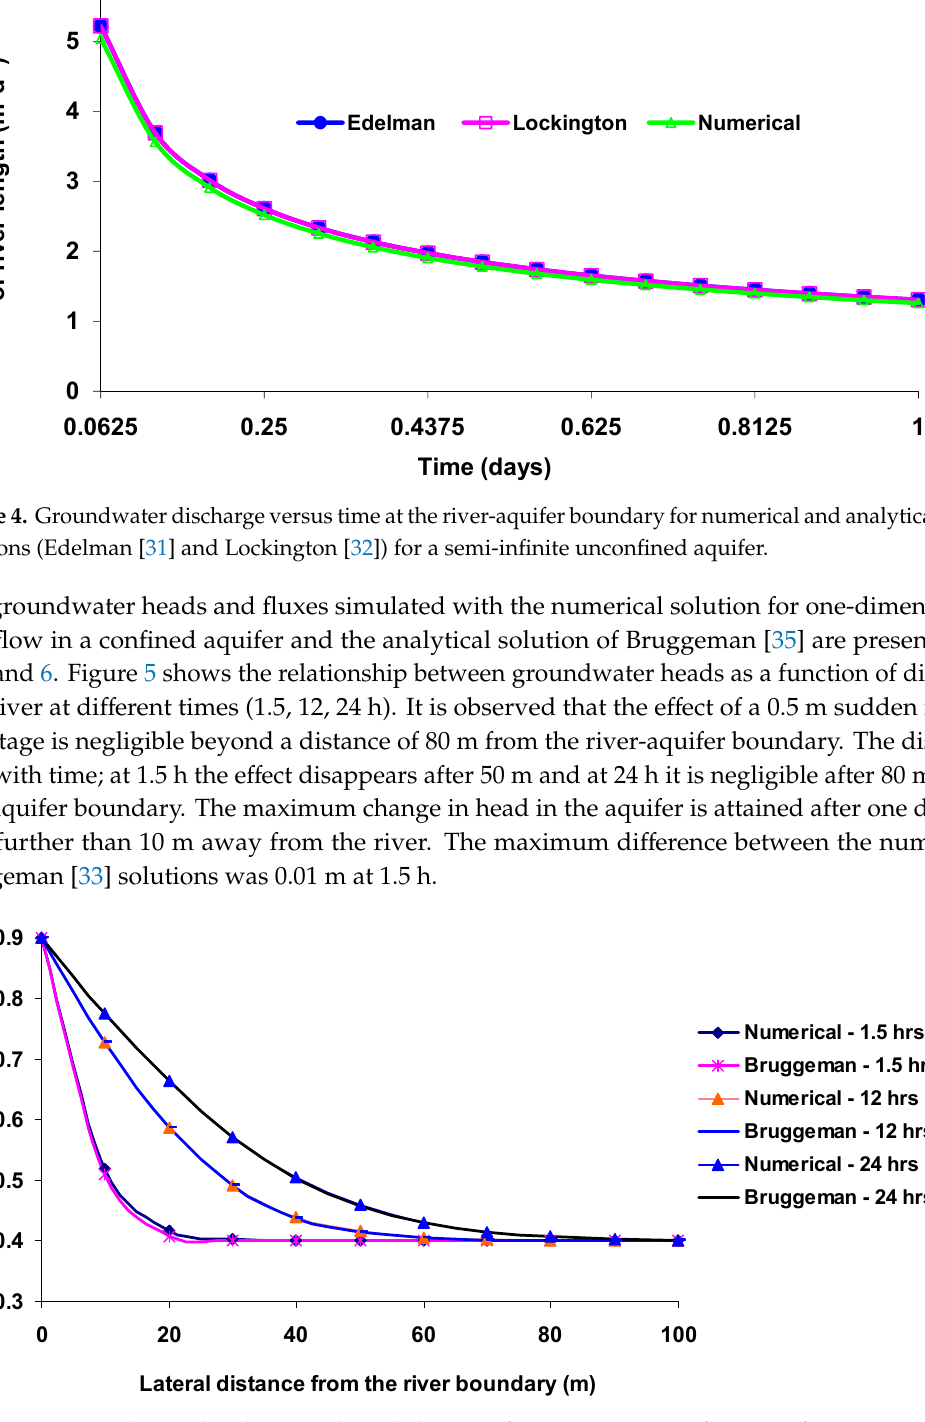
Figure 6. Groundwater fluxes versus lateral distance from river at specific times (1.5, 12, and 24 h) for numerical and Bruggeman [33] solutions for a confined aquifer. 3.2. Two-Dimensional Numerical Solution in an Unconfined Aquifer The two-dimensional groundwater module for an unconfined aquifer is applied to the Aa River aquifer, Belgium (based on data from [42,43]) (Figure. 7).